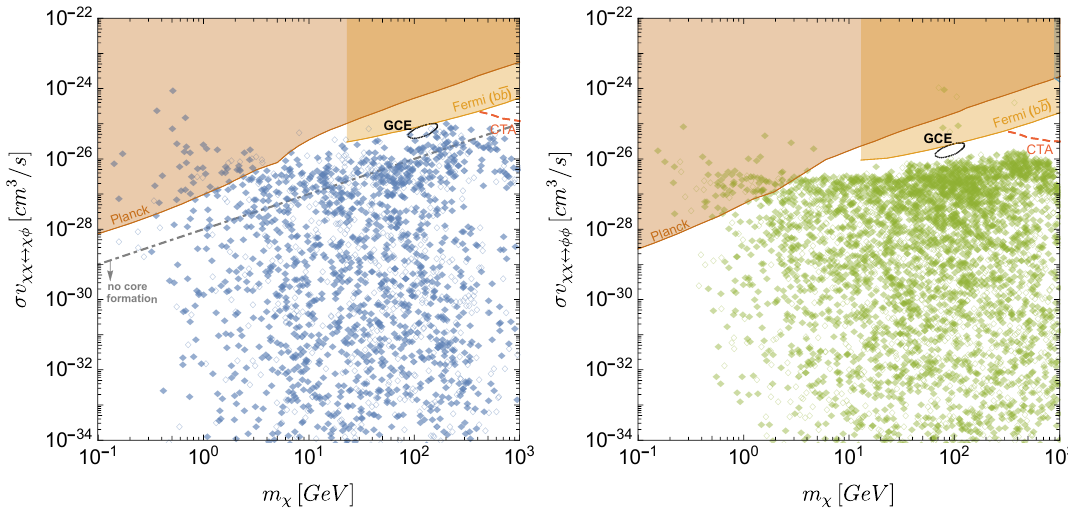
Figure 5 . The results of the scan showing the points that correspond to Ω h 2 = 0 . 12 ± 0 . 012 with the superimposed indirect detection limits. Filled diamonds indicate the points that are within the reach of the future searches of the mediator φ , cf. figure 4 while the empty ones are beyond these prospects. The existing limits from Planck measurements of the CMB [1] (light brown) and Fermi-LAT+MAGIC combined analysis of the gamma-ray observations of dSphs [52] (orange) are shown as shaded regions, while the dashed red line gives the projected sensitivity of the CTA for the b ¯ b channel [53]. Left : points with dominant semi-annihilation σv χχ → χφ > σv χχ → φφ projected onto the ( m χ , σv χχ → χφ ) plane. The black ellipse shows the best fit region for the GC excess recasted from [54]. The dot-dashed gray line indicates the semi-annihilation cross section below which there is no appreciable core formation in the dSph by the self-heating of DM [17]. Right : points